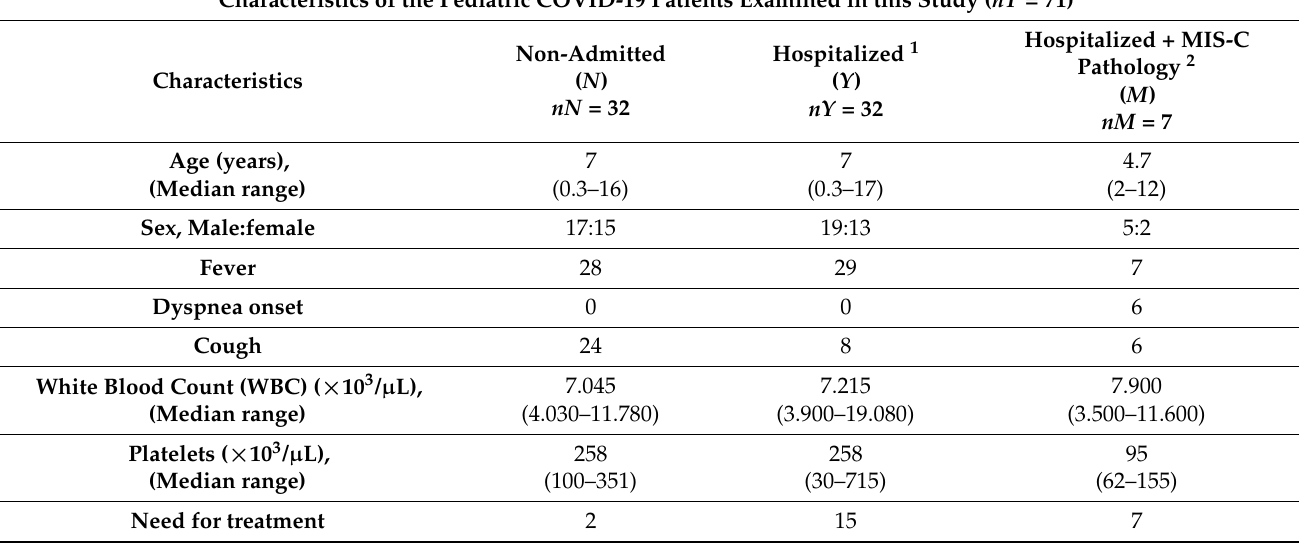
Table 1. A summary of the pediatric COVID-19 patients examined in this study. Characteristics of the Pediatric COVID-19 Patients Examined in this Study ( nT = 71)